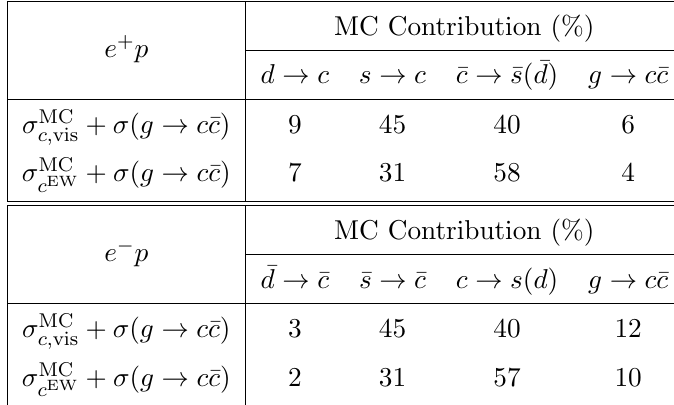
Table 1. MC contributions (%) of charm subprocesses to (cid:27) MC ADNE. The (cid:12)rst two columns ( d ! c and s ! c for e + p collisions, for example) re(cid:13)ect the contri- butions from the QPM processes described in (cid:12)gure 1 (i) and a higher-order correction described in (cid:12)gure 1 (iii). The contribution of the (cid:12)nal-state gluon splitting described in (cid:12)gure 2 enters the fourth column ( g ! c (cid:22) c